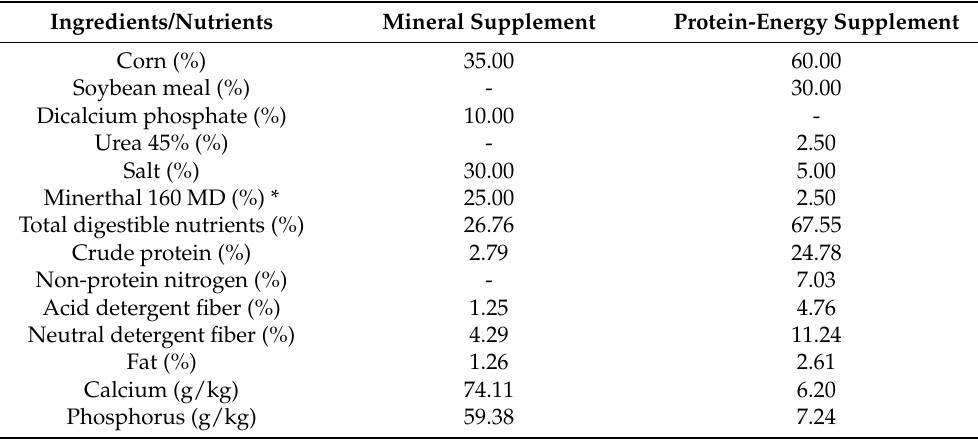
Table 4. Ingredients and nutrients content of the supplement for dams.